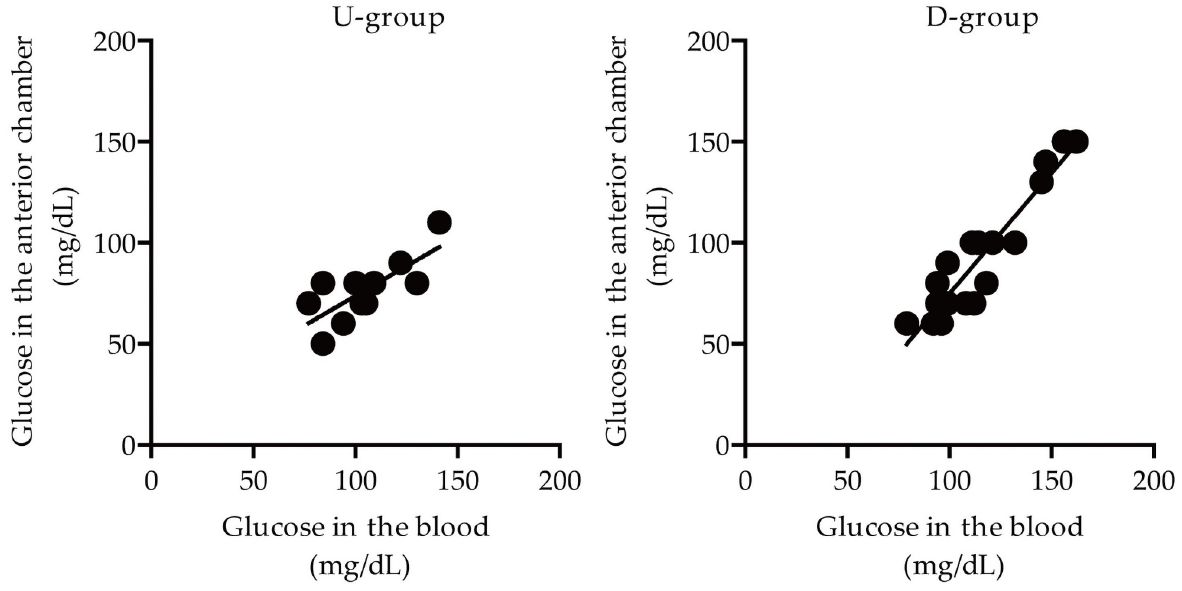
Fig 5. Visualization of a correlation on glucose levels between the anterior chamber and blood in Study 1 and 2 subjects with cataracts based on the values in Table 4. Dots represent the measured glucose levels. Lines represent the linear fit of the data points. U: up, D: down.